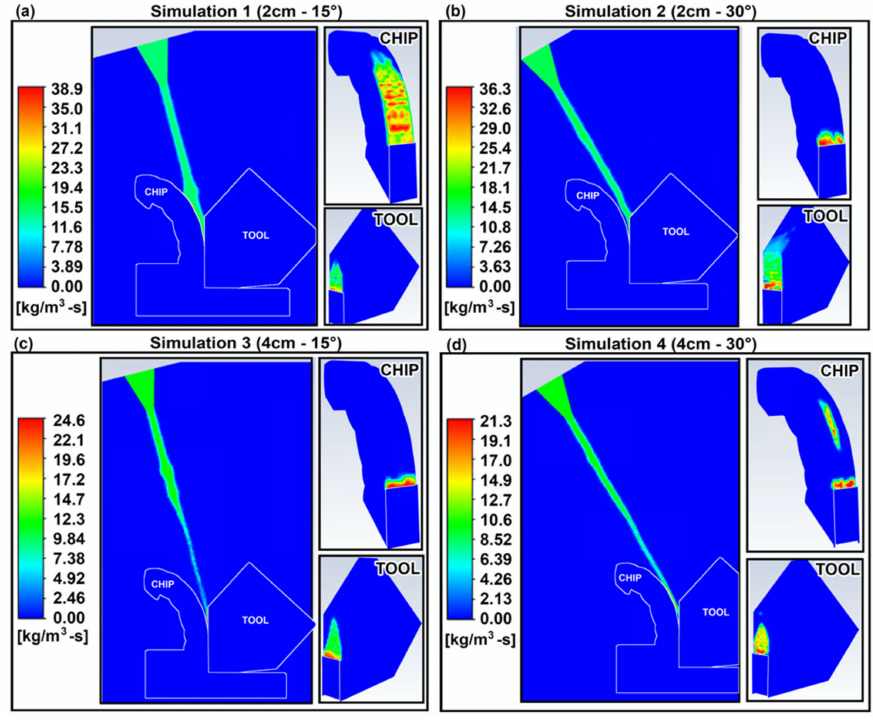
Figure 7. Evaporation rates (in kg/m 3